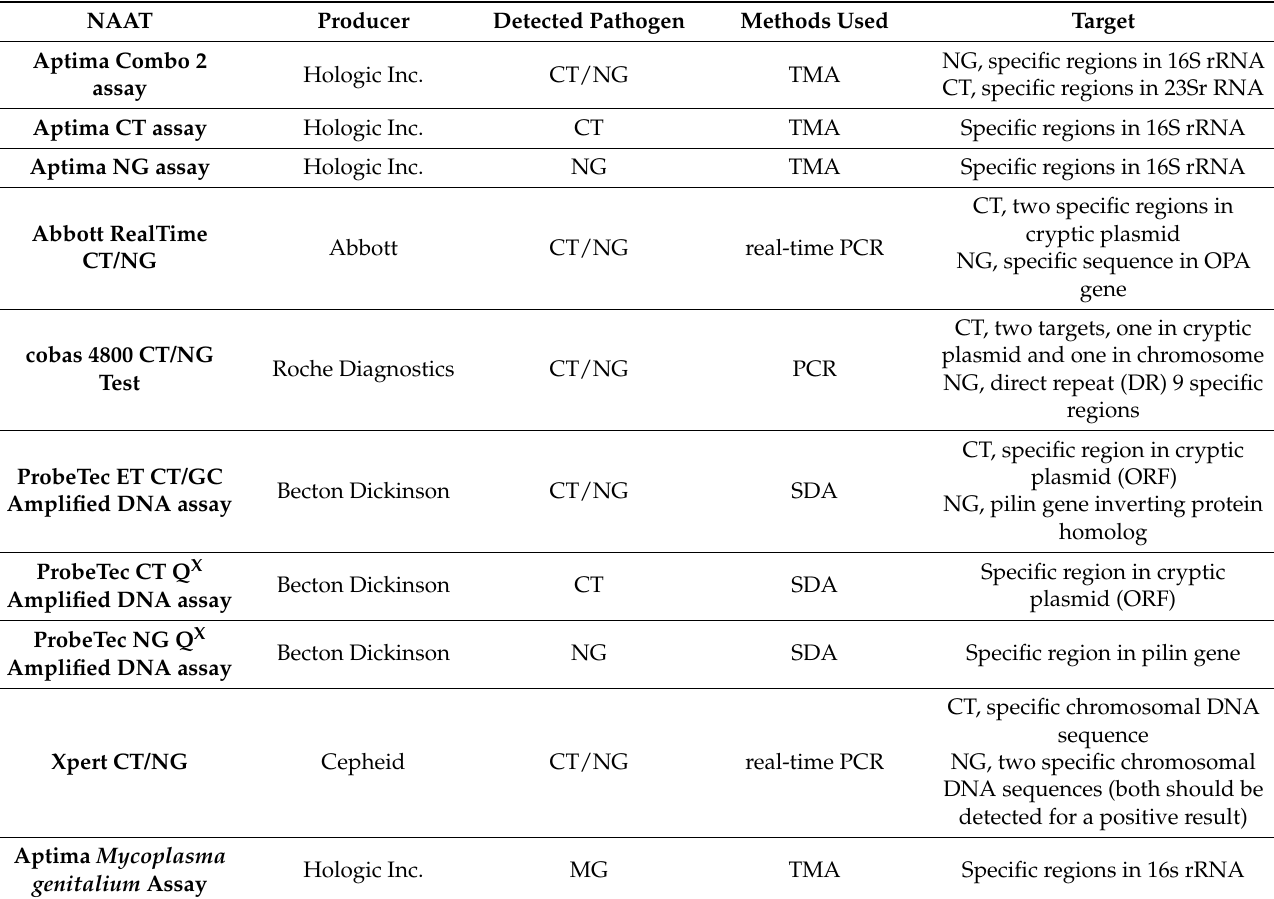
Table 2. FDA-approved tests utilized in the diagnosis of NG- N. gonorrhoeae, CT -C. trachomatis and MG -M. genitalium . SDA: strand displacement amplification, TMA: transcription-mediated amplification, ORF- open reading